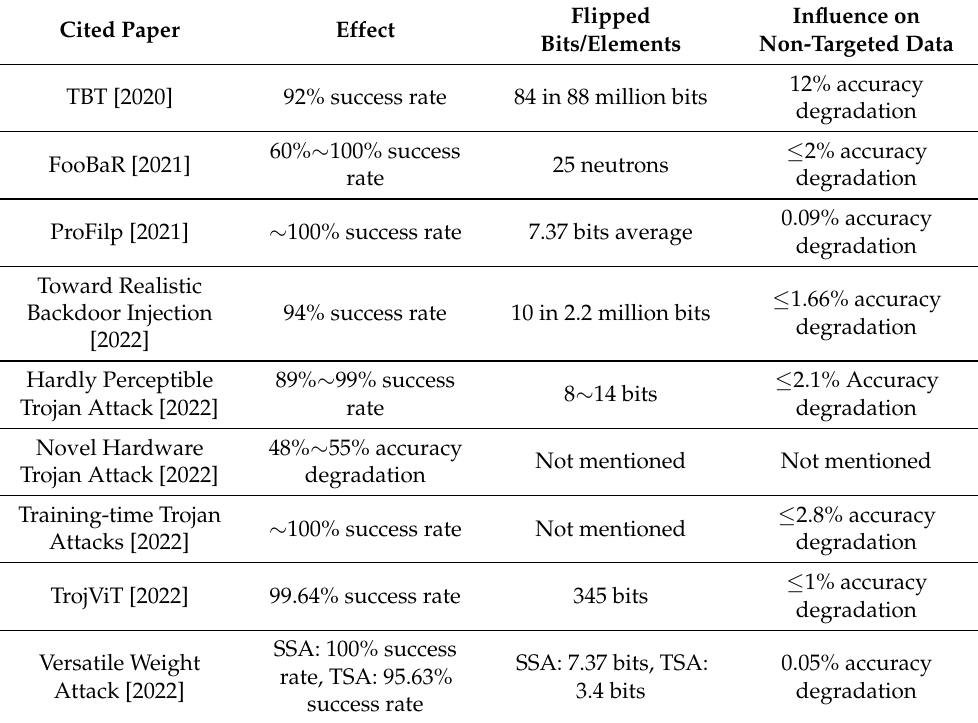
Table 7. The results of bit-flip-based trojan-related